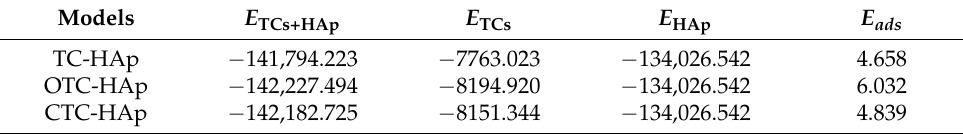
Table 1. Adsorption energy between TC, OTC, CTC, and HAp surfaces (Units: eV). Models